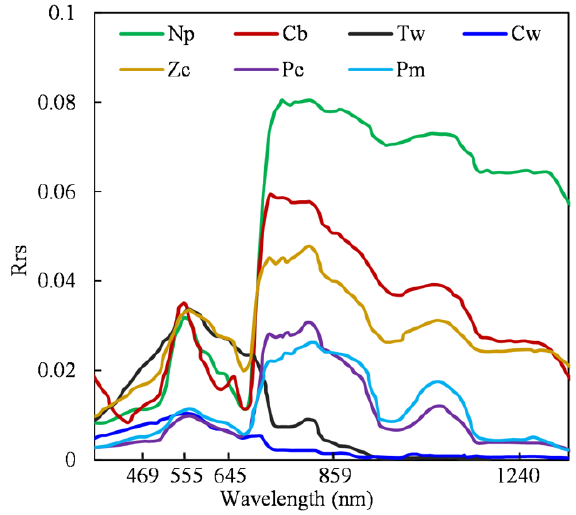
Figure 5. In situ measured water surface spectra with typical characteristics of Lake Taihu, featuring Nymphoides peltatum (Np), Cyanobacteria blooms (Cb), Turbid water (Tw), Clear water (Cw), Zizania caduciflora (Zc), Potamogeton crispus (Pc), and Potamogeton malainus (Pm).